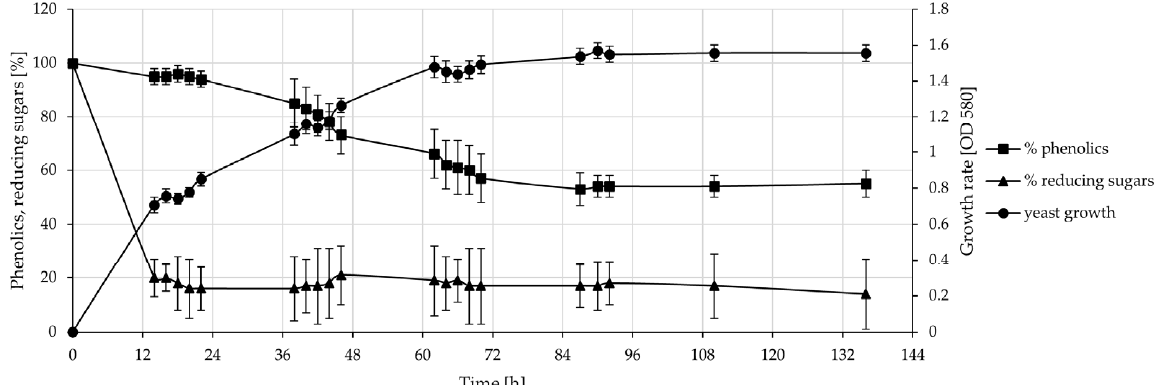
Figure 3. Fermentation of RODW by indigenous yeast RODW isolates. Mean data for 23 isolates for a period of 136 h. Left ordinate represents the phenolics and reducing sugar content as a percentage of their initial content in RODW prior to fermentation. Right ordinate presents the yeast growth rate through optical density (OD 580 ) of the cultures. The RODW fermentations by the tested indigenous RODW isolates were performed in triplicate. Each point is an average ± SD of results from RODW fermentation by 23 different indigenous yeast isolates.